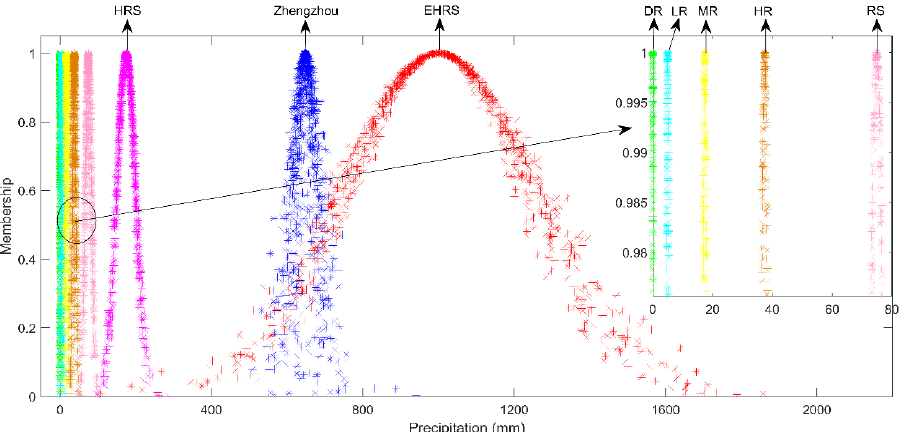
Figure 3. Qualitative assessment of the precipitation grade.